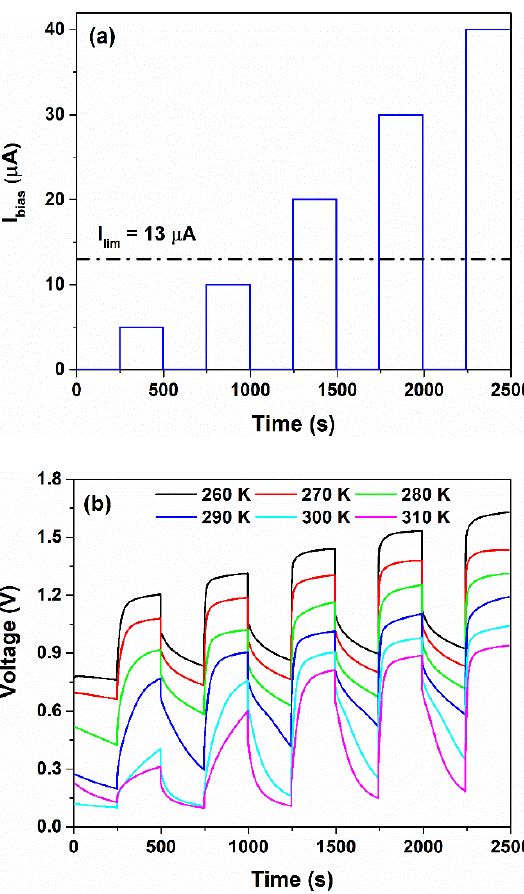
Figure 7. Time evolution of the ( a ) bias current profile and the ( b ) corresponding voltage measured across the device under operating conditions, respectively.